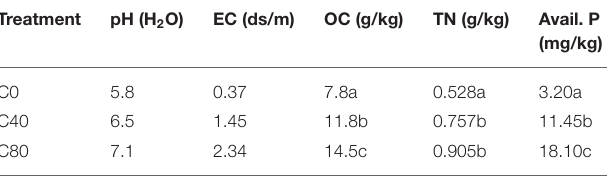
TABLE 6 | Effect of compost application on some residual soil